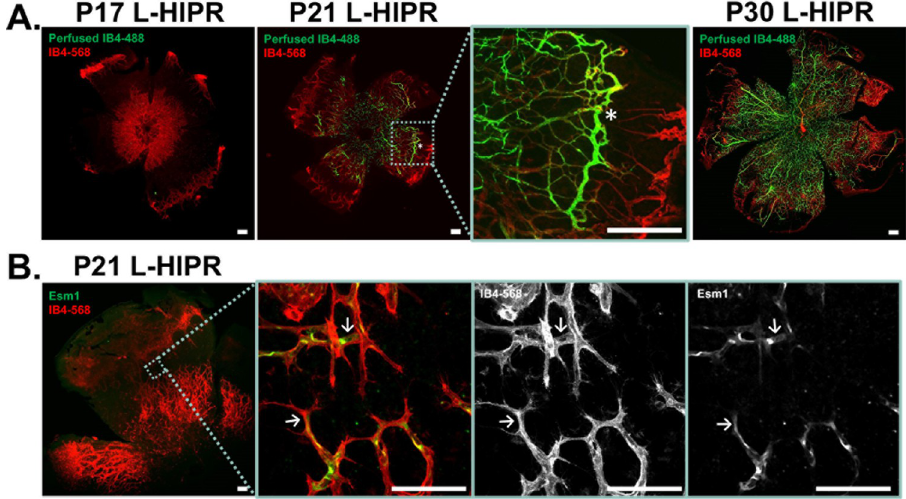
Fig 3. Anomalous retinal vascular development, with two opposing angiogenic fronts, and transient circumferential vasculature is observed in L-HIPR. (A) Alexa488 conjugated IB4 (green) was delivered in vivo via cardiac perfusion to highlight functional blood vessels. Retinal flat-mounts were prepared with Alexa568 conjugated IB4 (red) labeling all blood vessels. At P17 in L-HIPR no green signal is seen signifying that these vessels were not perfused. By P21 L-HIPR, perfusion is seen in the central retina, but peripheral vessels remain non-perfused. The light blue inset at P21 L-HIPR shows a region of interest displaying abnormal blood vessels traversing the retina circumferentially (marked with asterisk), which we suspect is persistent hyaloidal vasculature invading the retina. P30 L-HIPR shows mostly perfused retina from the optic nerve to periphery with resolution of the circumferential vasculature. (B) P21 L-HIPR flat-mounts immunolabeled with the tip-cell marker Esm1 (green) and blood vessels marked with IB4 (red). The light blue insert shows a region of interest where central and peripheral blood vessel fronts display IB4+ filopodia and Esm1+ tip-cells, indicating two angiogenic fronts that meet in the retinal mid-periphery. Scale bars equal 500 μ m.